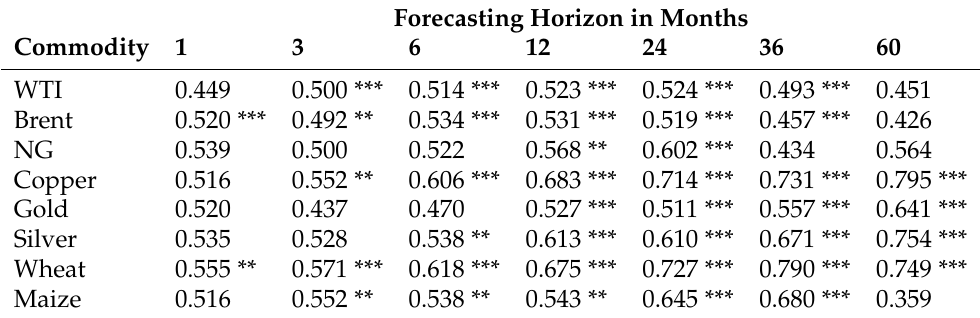
Table 4. Fractions of correct sign of change predictions for real commodity price